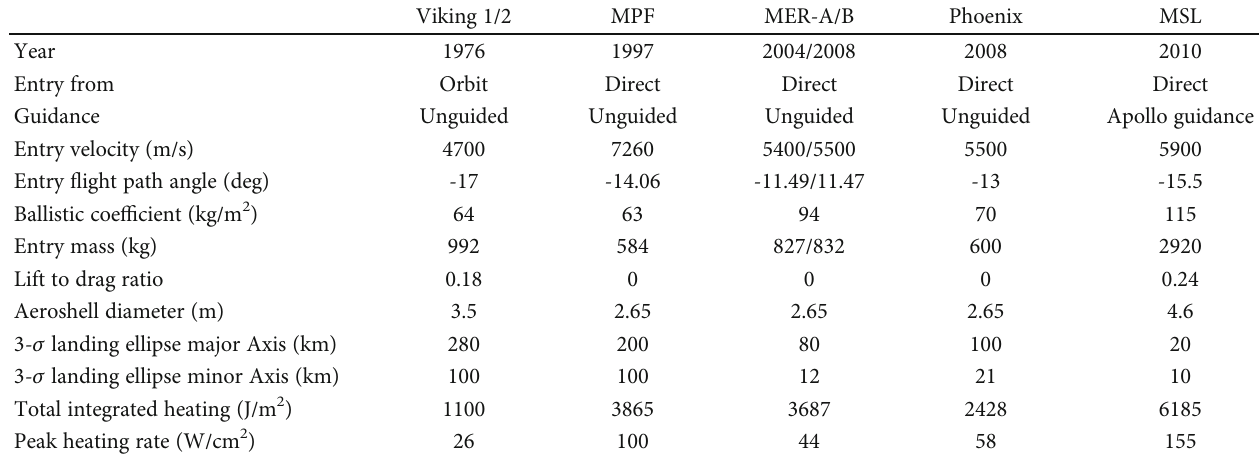
Table 1: Summary of previous successful Mars EDL missions [3,